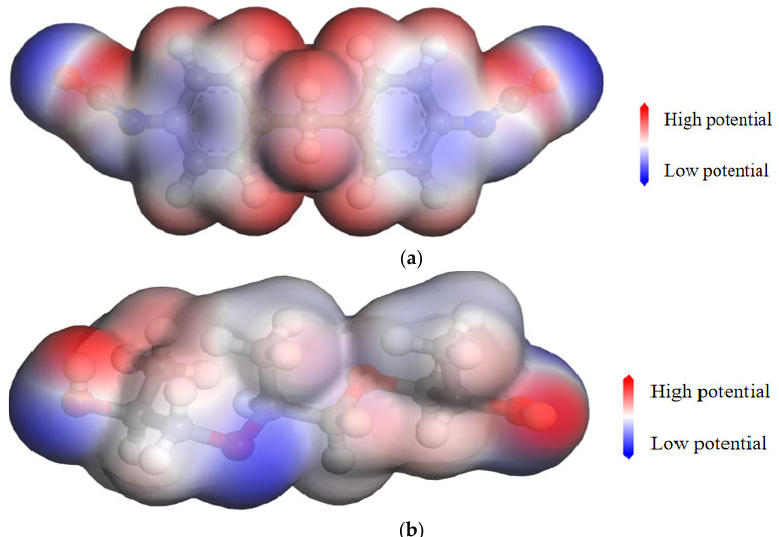
Figure 4. Surface electrostatic potential of isocyanate and polyether polyol: ( a ) Surface electrostatic potential of MDI isocyanate; ( b ) Surface electrostatic potential of PPG polyether polyol.